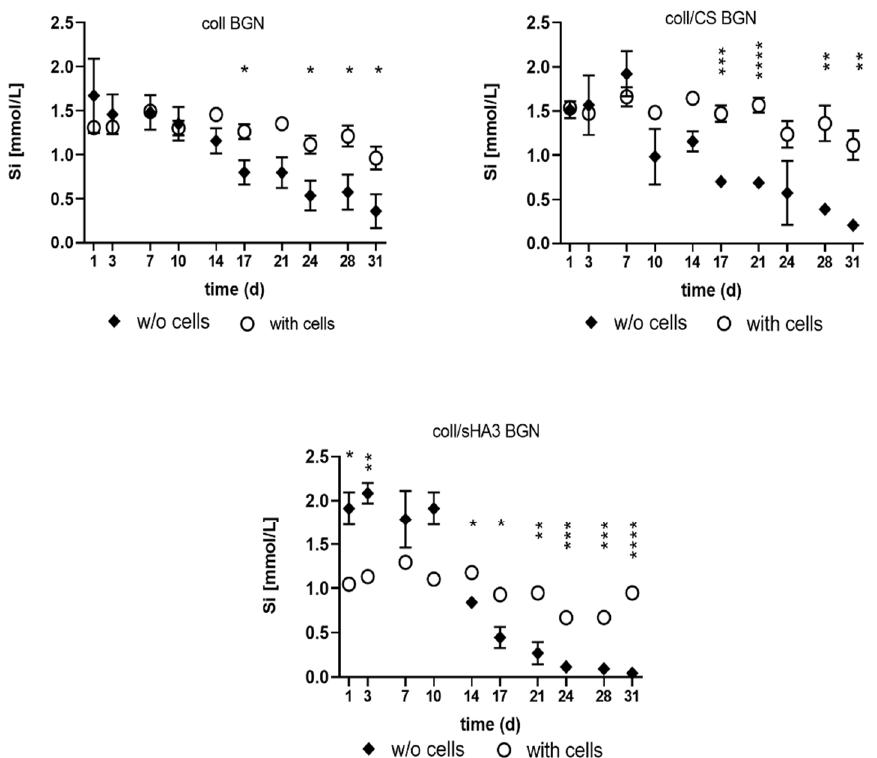
Figure 7. Silicon ion concentration after incubation of the BGN-containing coatings with cell culture medium (DMEM, 10% FCS, plus osteogenic supplements) in the presence and absence of cells. n = 4, average +/ − standard deviation, two-way ANOVA followed by Sidak’s multiple comparisons revealed significant differences between cell-containing and cell-free samples as follows: * p < 0.05, ** p < 0.01, *** p < 0.001, **** p < 0.0001.